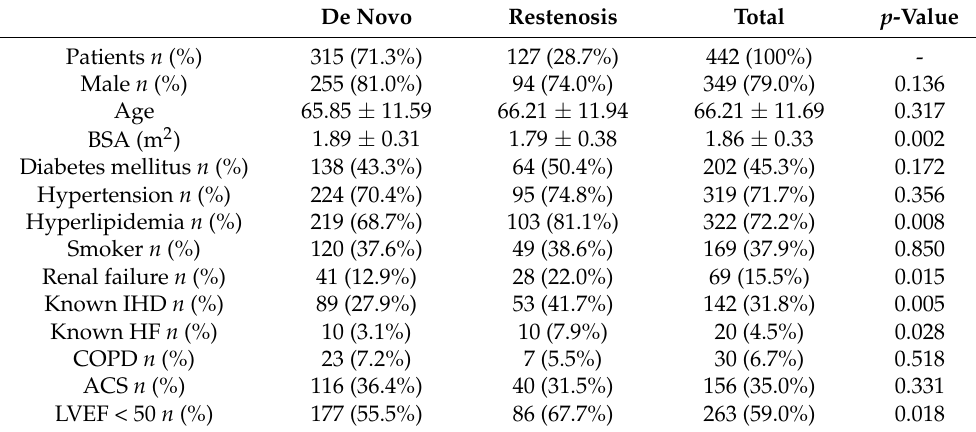
Table 1. Patient